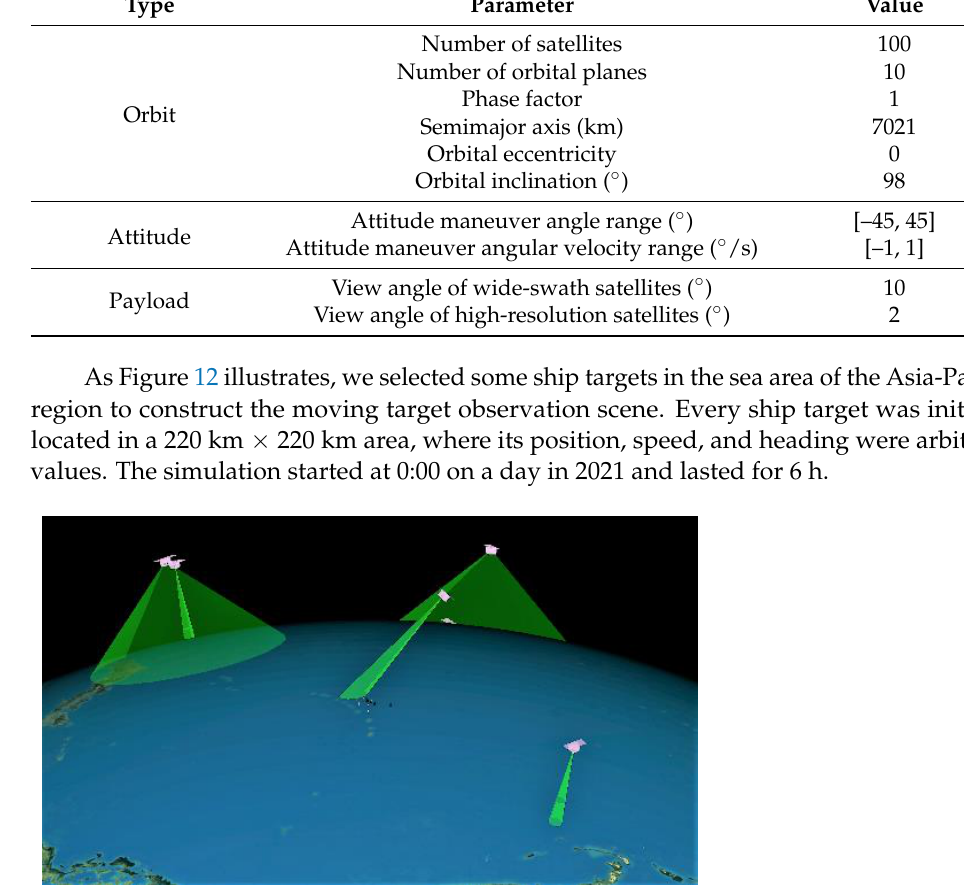
Table 6. Parameters of the satellite constellation.